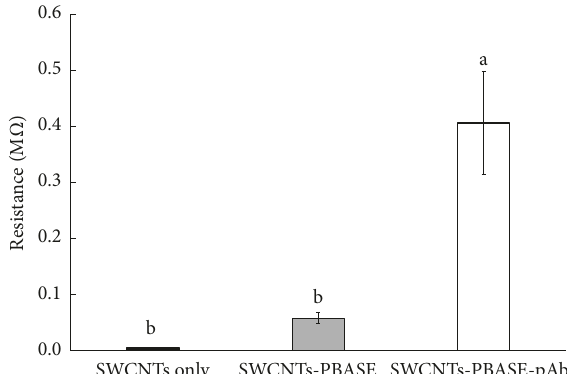
Figure 3: Resistance after immobilization of SWCNTs, 1-pyrenebu- tanoic acid, succinimidyl ester (PBASE), and anti- Staphylococcus aureus polyclonal antibodies (PABS) to the sensor platform. Error bars represent standard deviation ( 𝑛 = 3 ). Different letters (a-b) rep- resent significant differences among the samples at 𝑃 < 0.05